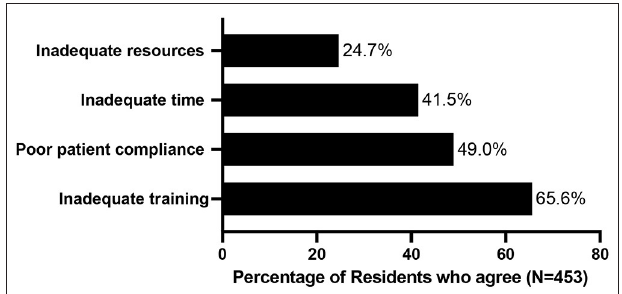
FIGURE 2 | Barriers to Effective Dietary Counseling.